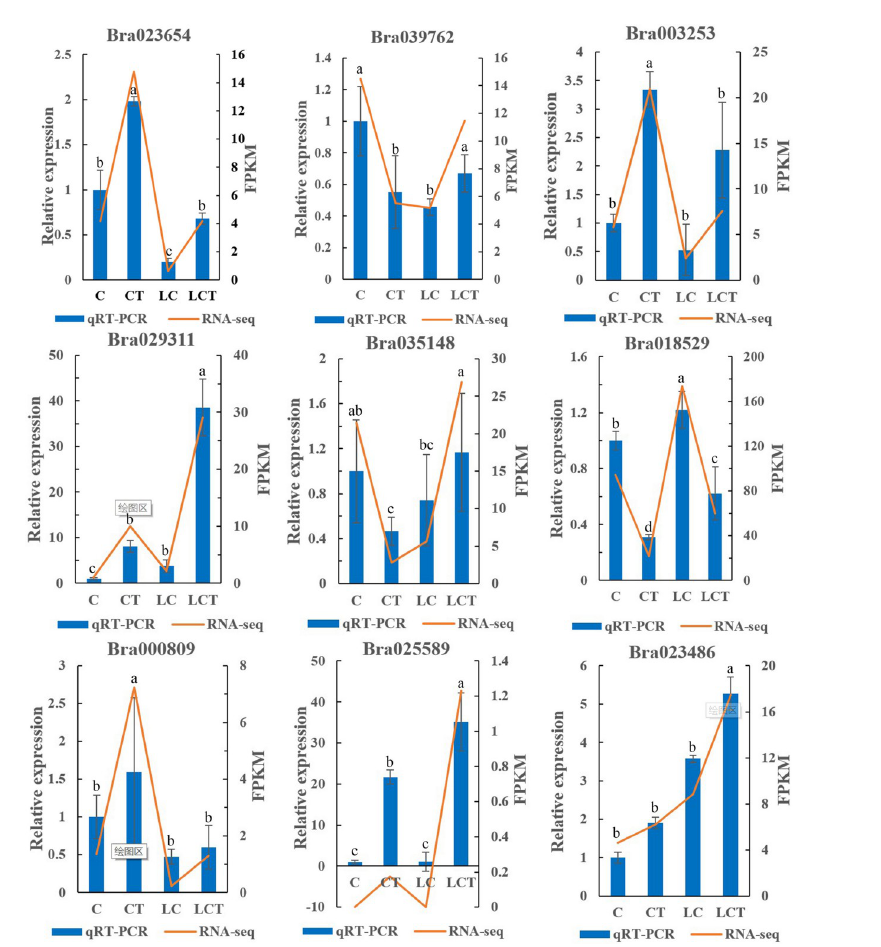
Fig 11. qRT-PCR verification of differential genes.